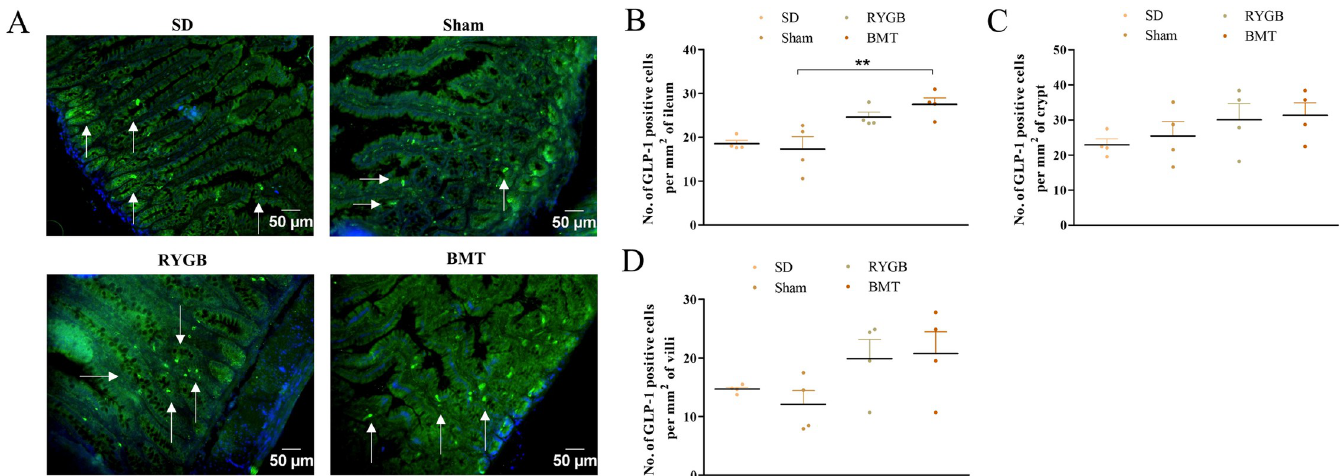
Fig 4. Effects of RYGB, BMT and sham surgery on GLP-1 positive cell distribution in the ileum of ZDSD rat intestine. (A) Representative images showing GLP-1 (green); arrows indicate GLP-1 positive cells. Nuclei are demonstrated using DAPI staining (blue). (B) number of GLP-1 positive cells per mm 2 of ileum, (C) number of GLP-1 positive cells per mm 2 of crypt and (D) number of GLP-1 positive cells per mm 2 of villi analyzed in ileum sections. Normal SD rats are included for comparison. Values are mean ± SEM (n = 4) with statistical significance evaluated using one-way ANOVA. �� p < 0.01 compared to sham rats. Analyses carried out on ~200 cells per